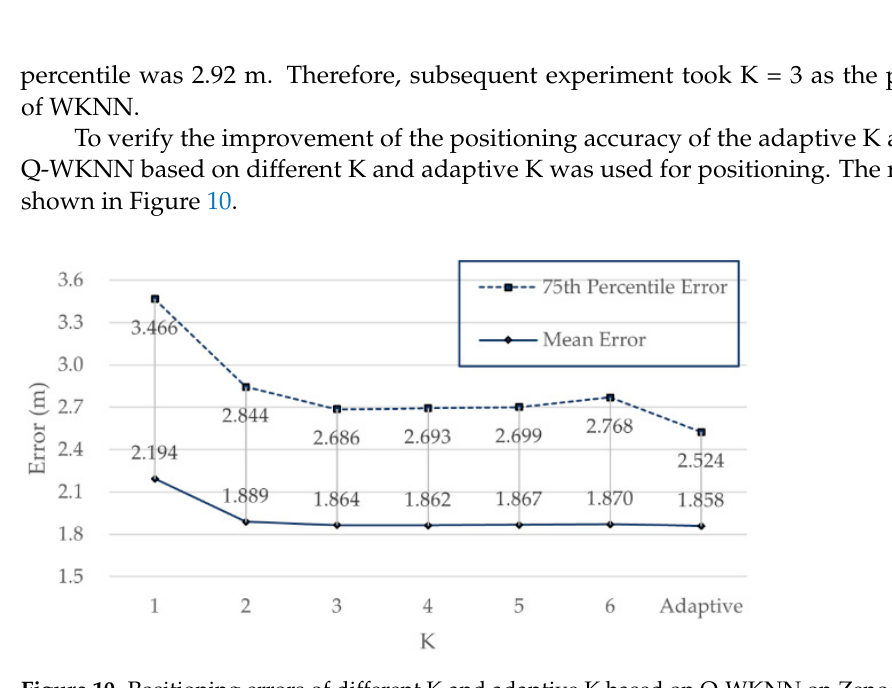
Table 3. Positioning errors of different algorithms on